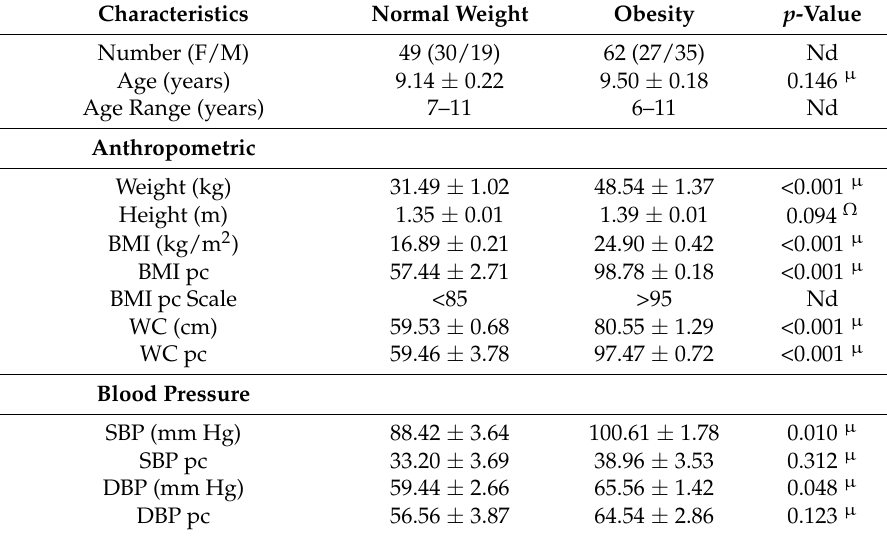
Table 1. Clinical characteristics of 6–11-year-old